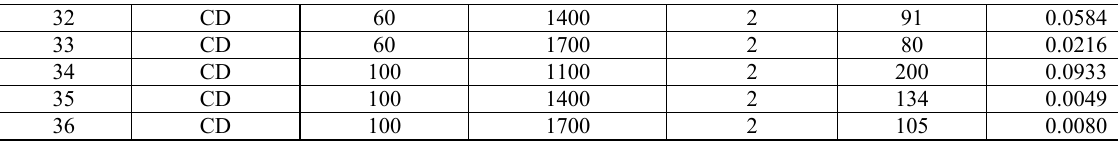
Table 6. The obtained results of grey relational analysis.